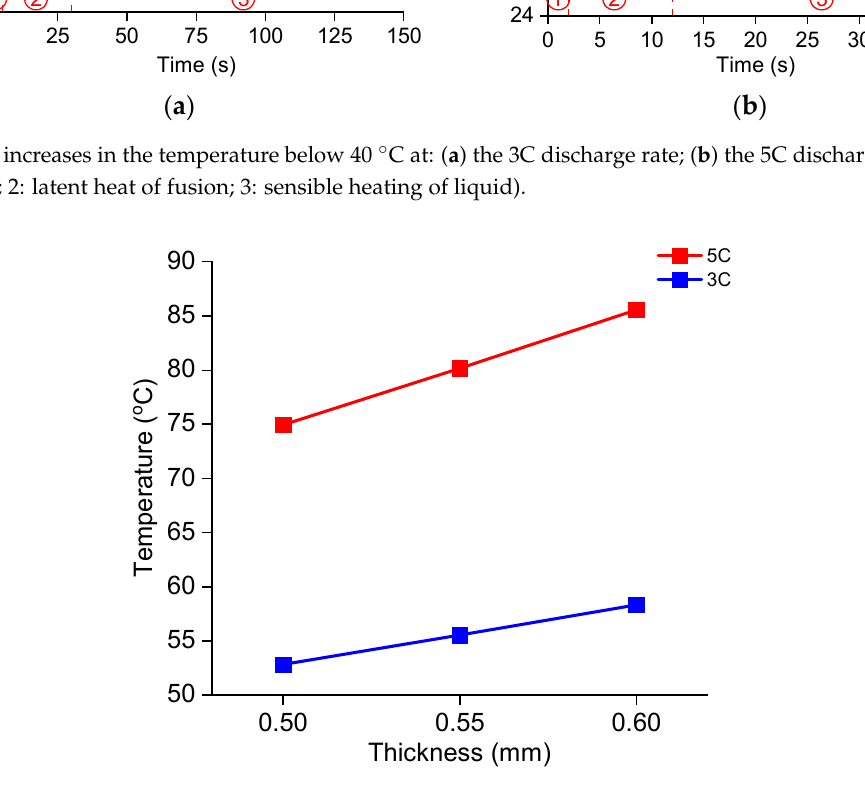
Figure 10. The highest battery temperature as a function of PCM thickness.